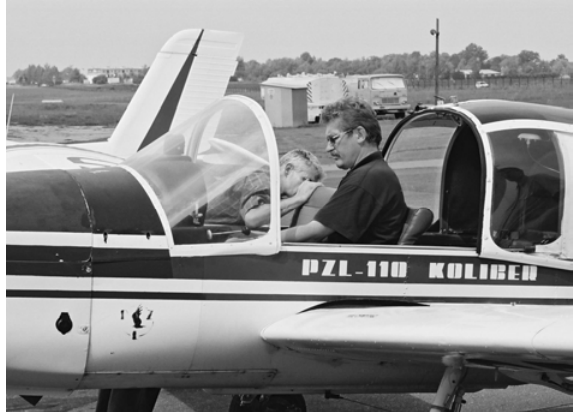
Fig 13 . PZL-110 “Koliber” aircraft: preparation for experimental